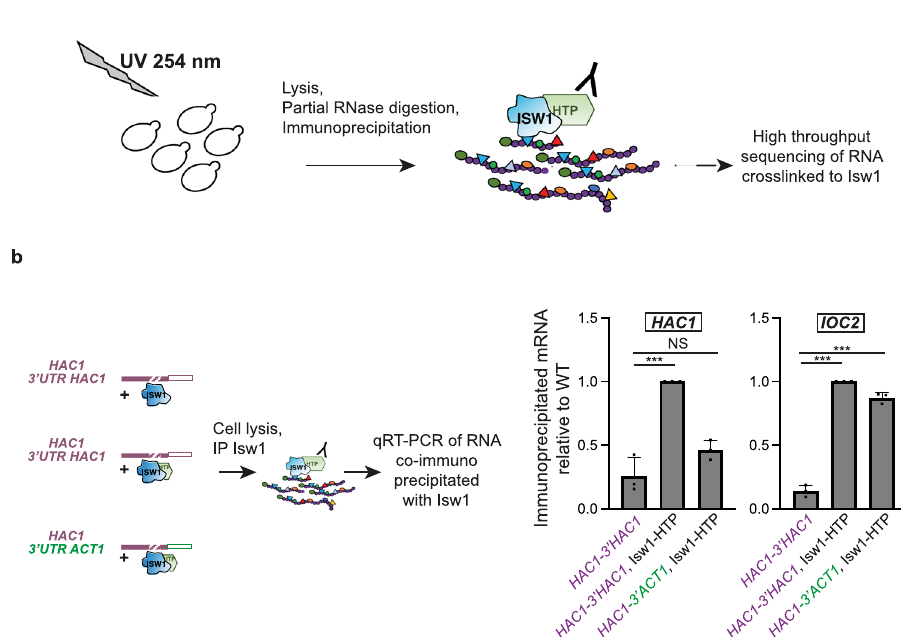
Fig. 1 | Isw1 interacts with the 3 ’ UTR of HAC1 mRNA. a Scheme depicting the identi fi cation of Isw1-bound transcripts by in vivo UV-crosslinking and analysis of cDNA.Growingyeastcellsexpressingdualaf fi nitytagged(HIS6-TEV-PrA)Isw1were UV-irradiatedwith254nmUVlighttocovalentlycrosslinkRNA-proteincomplexes, which were immunopuri fi ed under stringent wash condition to prevent the recovery of indirect RNA targets. After ligation of linkers, crosslinked RNAs were converted to cDNA, PCR ampli fi ed, and sequenced. b The interaction between HAC1 mRNAandIsw1ismediatedbyits3 ′ UTR.RIPassayswereperformedwithHTP